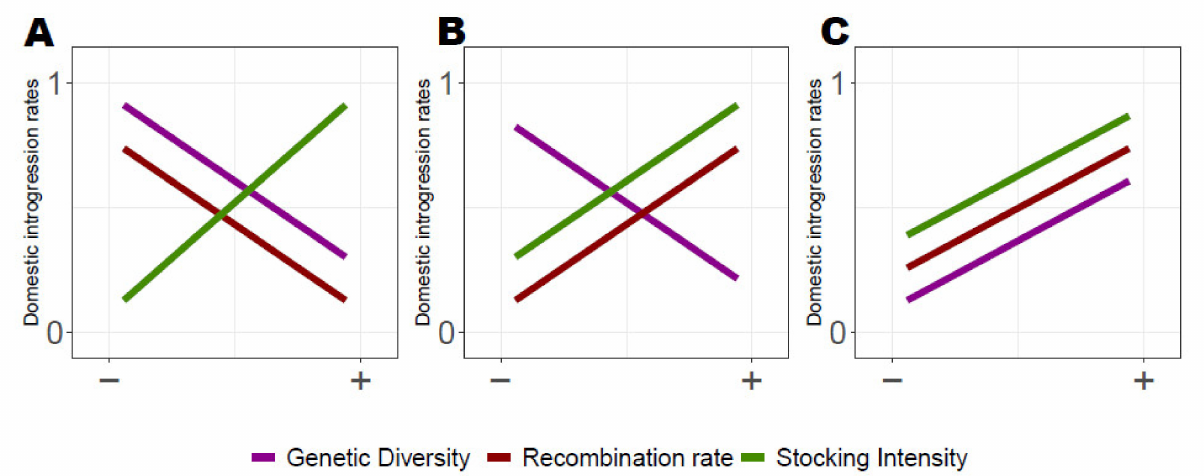
Figure 1. Predicted relationships between domestic ancestry rate, local recombination rate, local genetic diversity and stock- ing intensity. ( A ) Predicted relationship expected with associative overdominance (AOD), where more domestic ancestry are observed in low-diversity genomic region by masking the effects of potentially recessive deleterious mutation [13]. ( B , C ) Predicted relationship with negative epistasis where loci of incompatibility results in lower domestic ancestry in low recombining genomic regions. ( B ) Predicted relationship in presence of potential local beneficial alleles where lower diversity is expected due to the fixation of the beneficial alleles and higher introgression of domestic ancestry. ( C ) Predicted higher domestic ancestry in low-diversity genomic regions, namely due to the purge of incompatibility alleles [13,34]. X-axis illustrates the range of variation for each of the three variables (i.e., from lower to